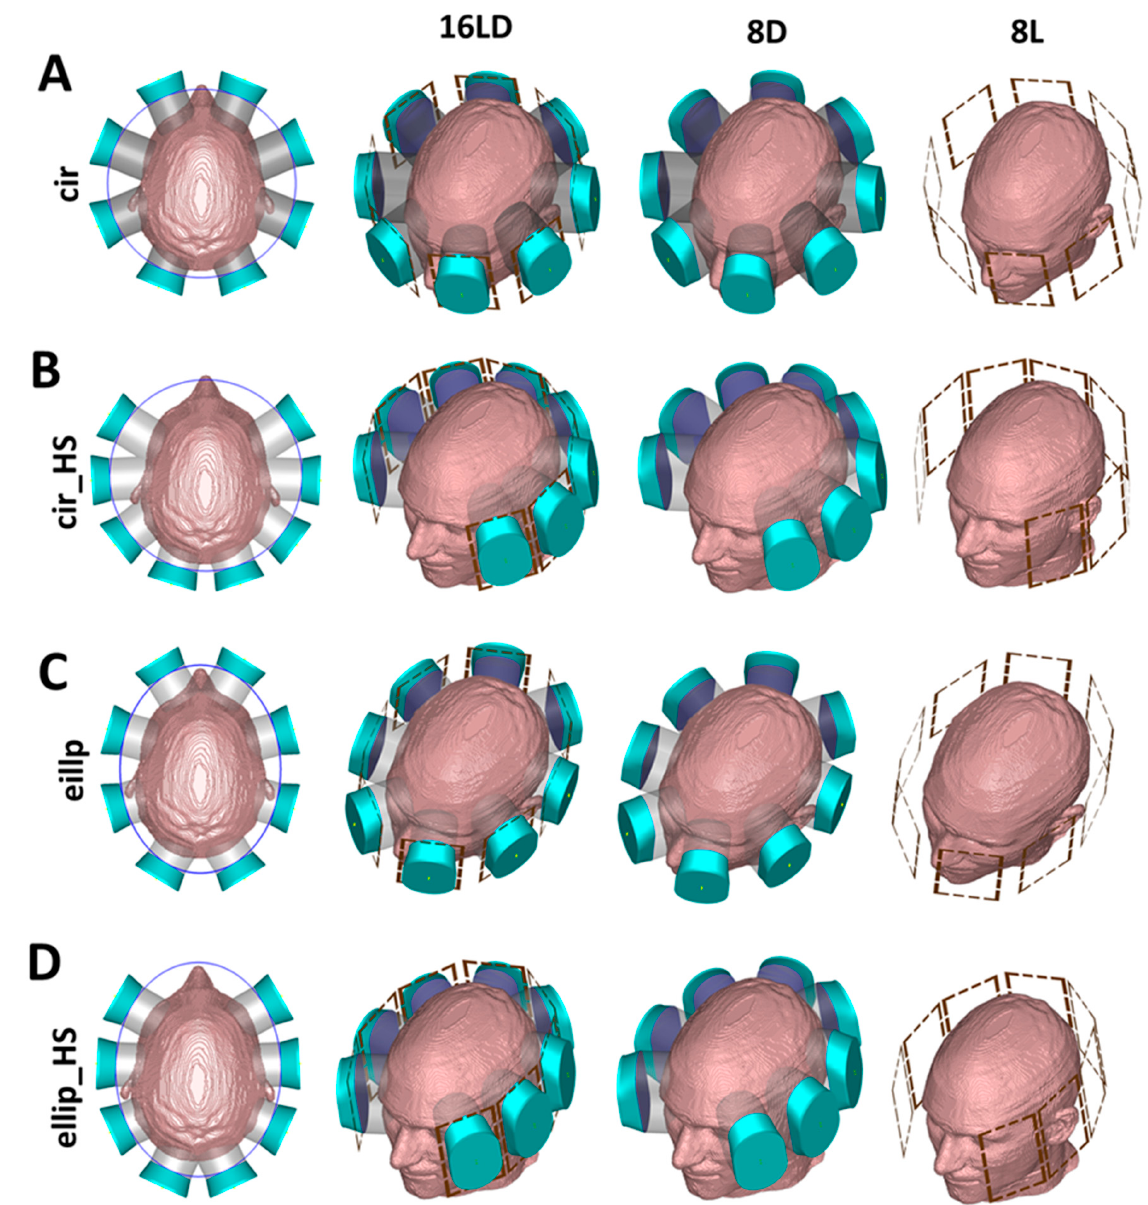
Figure 3. Overview of ThermalMR RF applicator configurations with 16LD, 8D and 8L variants around the head of Duke. Circular and elliptical array configurations were designed using 360 ◦ coverage, and the horse-shoe shape using arc = 270 ◦ coverage of the head. Arrangements of the loop+SGBT dipole building blocks are illustrated on the left column: ( A ) circular array (cir), ( B ) circular horse-shoe array (cir_HS), ( C ) elliptical array (ellip), ( D ) elliptical horse-shoe array